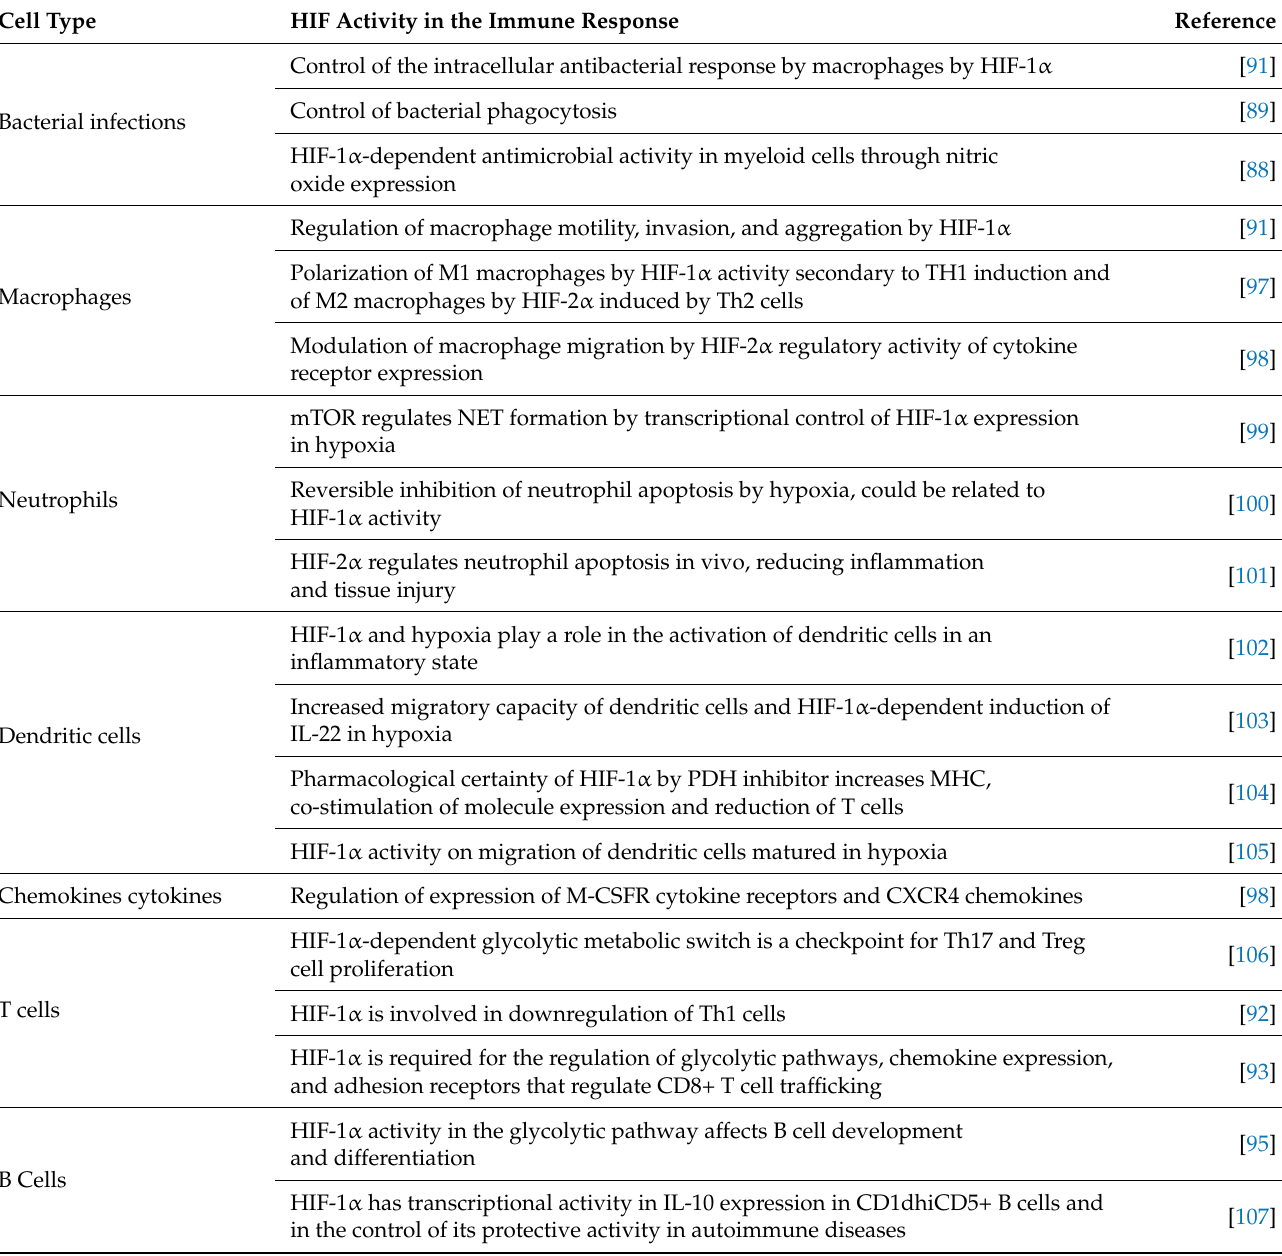
Table 2. Role of HIF-1 α and HIF-2 α in the immune